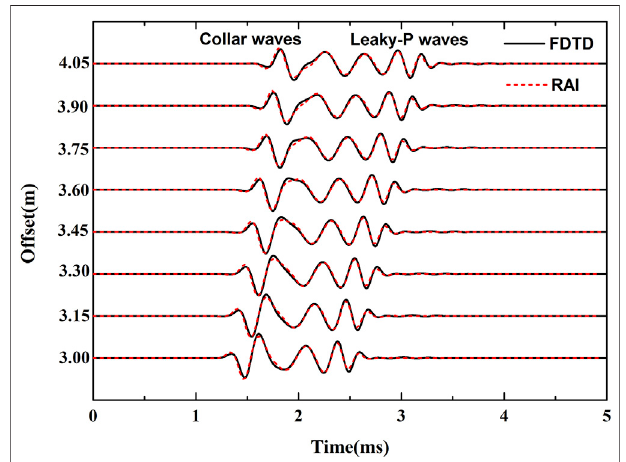
FIGURE 2 | Comparison between the modeling results of the numerical FDTD (black solid line) and semi-analytical RAI (red dot line) methods.